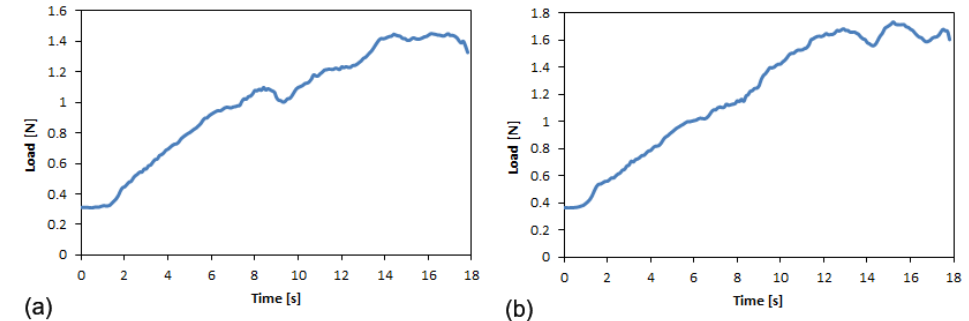
Figure 4. Typical load-time curves for PFA in longitudinal ( a ) and transverse ( b ) specimens.